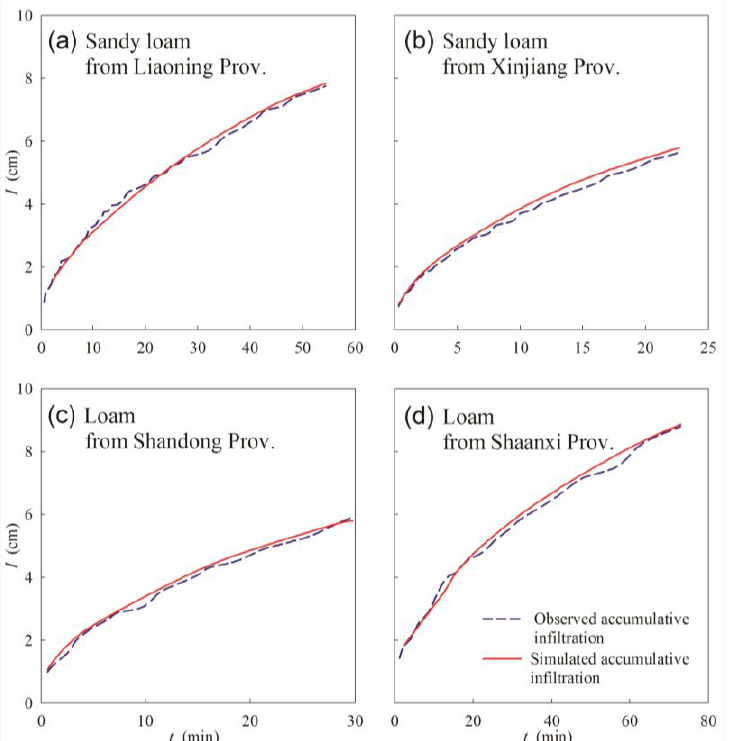
Figure 4. Comparisons of the observed and simulated cumulative infiltration methods (the data for observed cumulative infiltration are the mean value of the three replicates). ( a ) The experimental soil is sandy loam collected from Liaoning Province; ( b ) The experimental soil is sandy loam collected from Xinjiang Province; ( c ) The experimental soil is loam collected from Shandong Province; ( d ) The experimental soil is loam collected from Shaanxi Province.